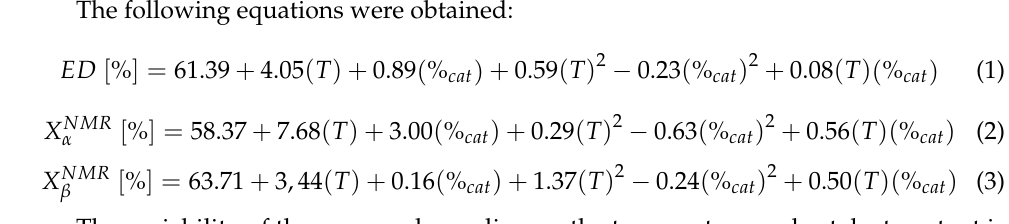
Table 4. Values of coded input variables.